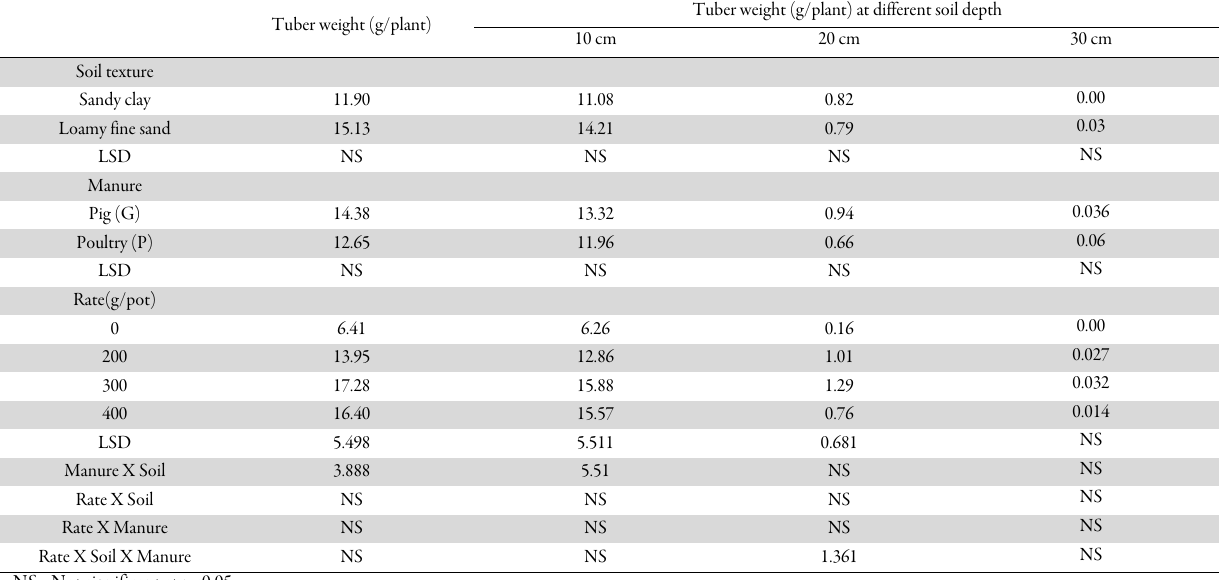
Table 9. Effect of soil texture and rates of poultry and pig manure on total tuber weight and weight of tiger nut tubers at 10, 20 and 30 cm depth of soil at harvest. Values are a mean of 5